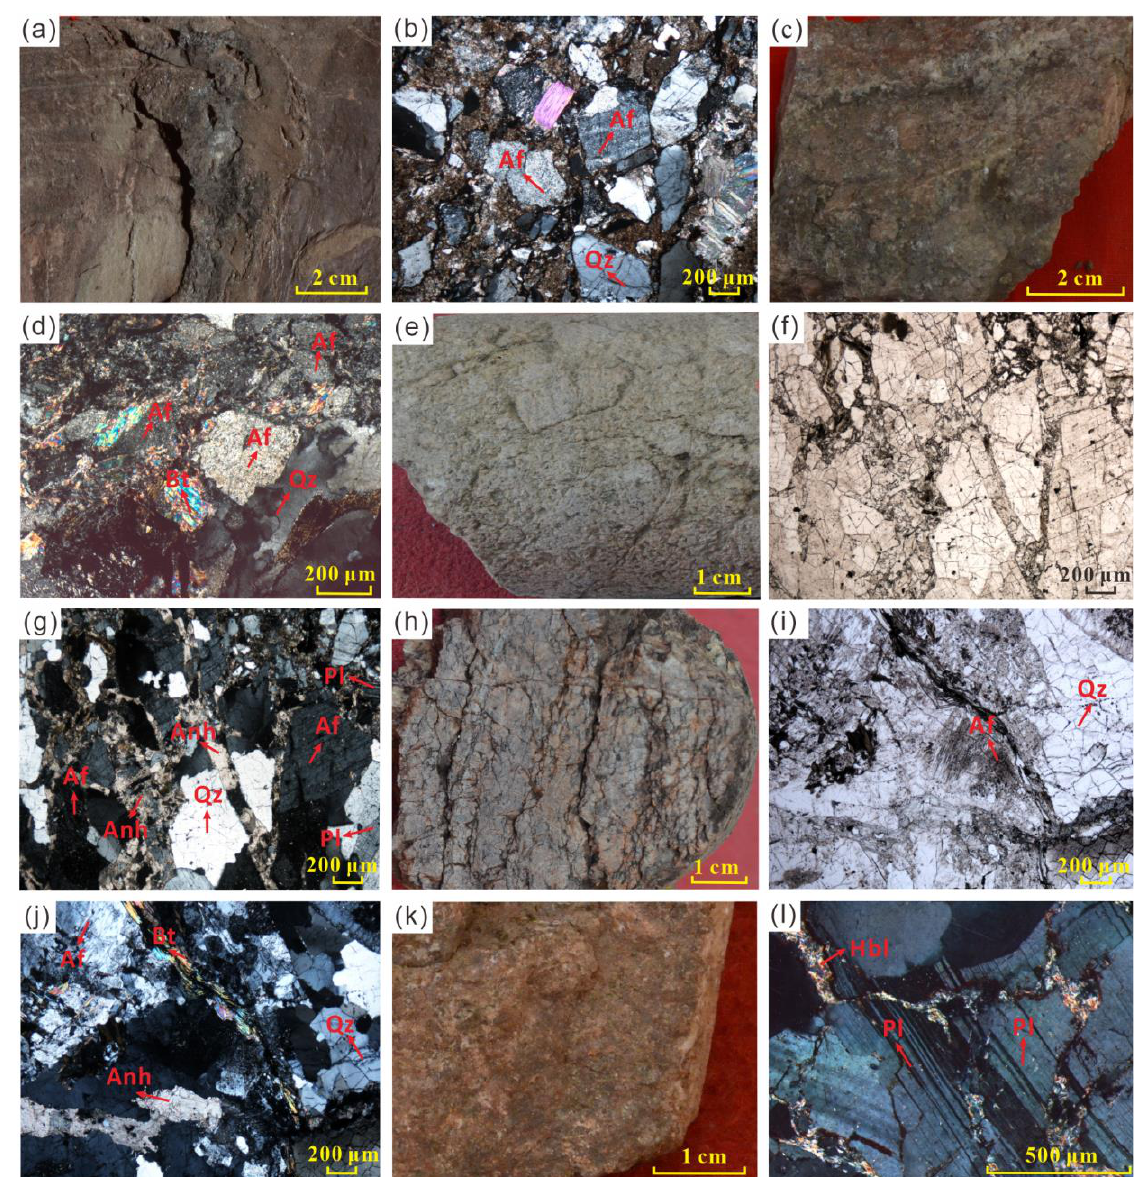
Figure 4. Petrography of granitoids that were exploited from distinct weathering crust belts. ( a ) Mudstone in soil layer, Dp1H23, 3070.88 m. ( b ) Greywacke in complete weathering layer, cross-polarized light, Dp1H23, 3075.48 m. ( c ) Granitic gneiss in complete weathering layer, Dp1H23, 3078.67 m. ( d ) Granitic gneiss in complete weathering layer, cross-polarized light, Dp1H23, 3078.67 m. ( e ) Granitoid in dissolution belt, N3, 2178.88 m. ( f ) Granitoid in dissolution belt, plane-polarized light, N3, 2178.88 m. ( g ) Granitoid in dissolution belt, cross-polarized light, N3, 2178.88 m. ( h ) Granite in disintegration belt, Dp306, 1907.8 m. ( i ) Monzonitic granite in disintegration belt, plane-polarized light, Dp306, 1916.76 m. ( j ) Monzonitic granite in disintegration belt, cross-polarized light, Dp306, 1916.76 m. ( k ) Granite in parent rock layer, Nb1, 3744.2 m. ( l ) Granite in parent rock layer, cross-polarized light, Nb1, 3744.2 m. Red arrows represent minerals. Qz: quartz, Af: alkali feldspar, Pl: plagioclase, Bt: biotite, Hbl: hornblende, Anh: anhydrite.